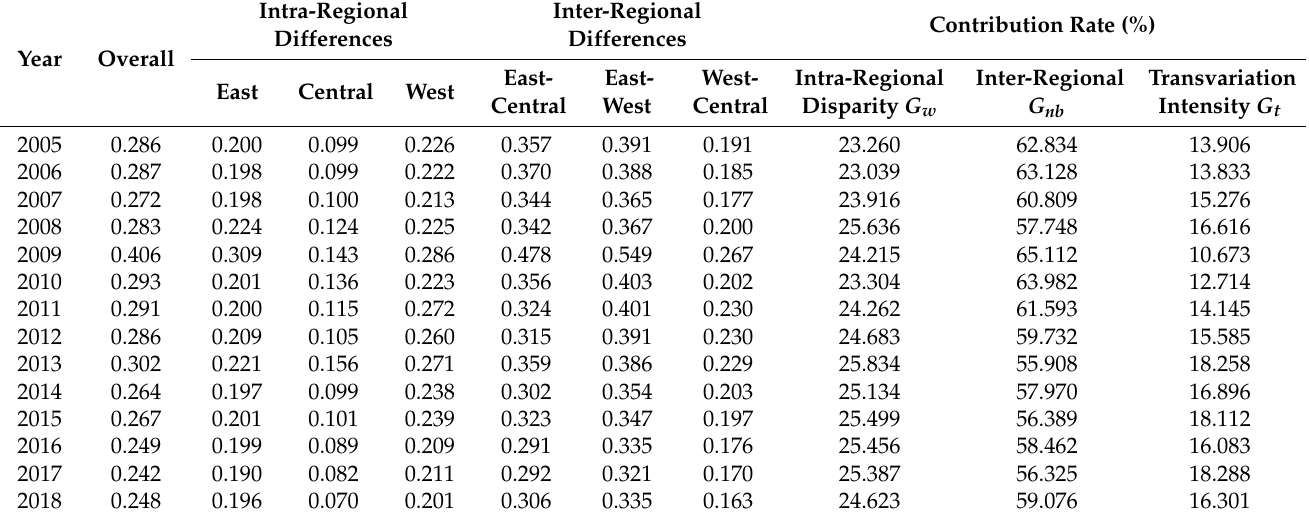
Table 1. Gini coefficient decomposition results of China’s green technology innovation efficiency